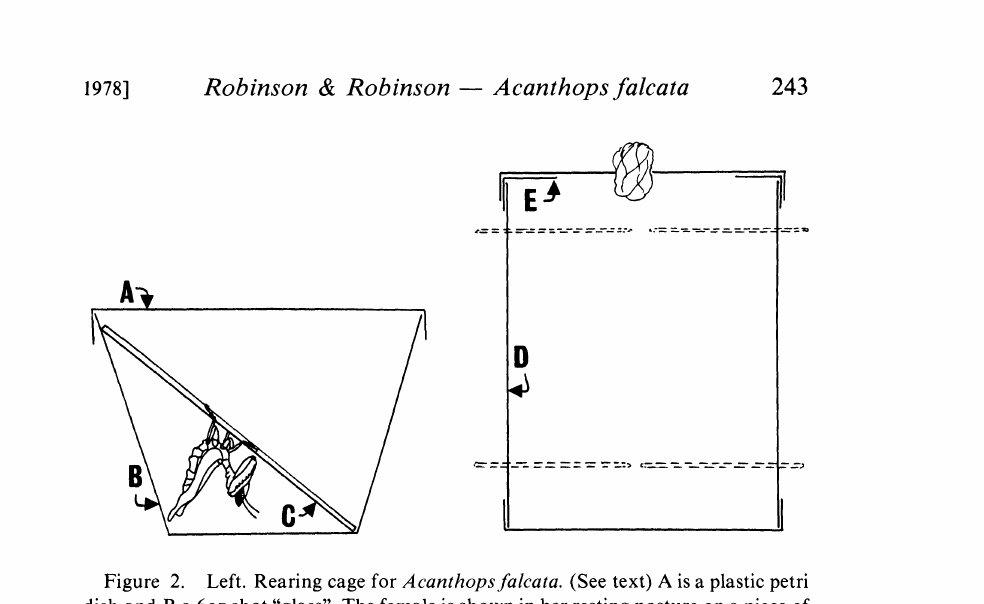
Figure 2. Left. Rearing cage for Acanthopsfalcata. (See text) A is a plastic petri dish and B a 6oz shot "glass". The female is shown in her resting posture on a piece of bamboo (C). Right. A larger cage, suitable for spiders and large rnantids. (See text) D is a cylinder of transparent acetate sheeting, 10crn high, joined with cellulose tape. E shows the double lid made from a plastic petri dish and cover. The inner section has a hole of 5 crn diameter cut frotn it. The outer section, which is plugged with a moist cotton ball, can be raised to introduce food, without disturbing the anitnal. The positions of the cylindrical toothpicks which provide web attachment points and footholds are